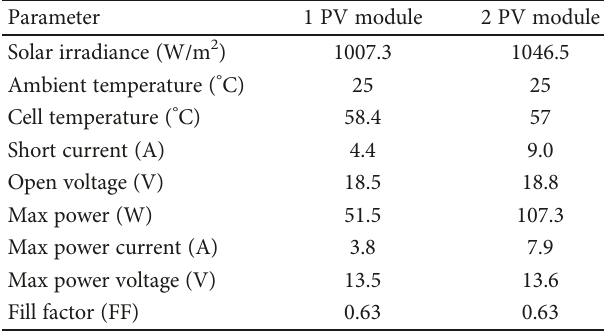
Table 2: Characterization of solar PV modules.